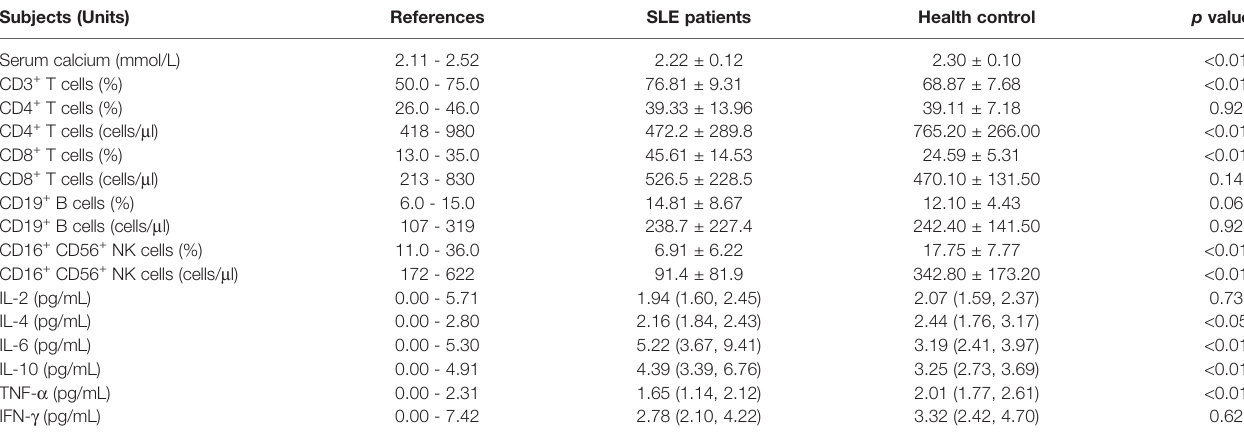
TABLE 2 | Calcium concentration, TBNK subsets and Th1/Th2 cytokines in peripheral blood of SLE patients and health people. Subjects